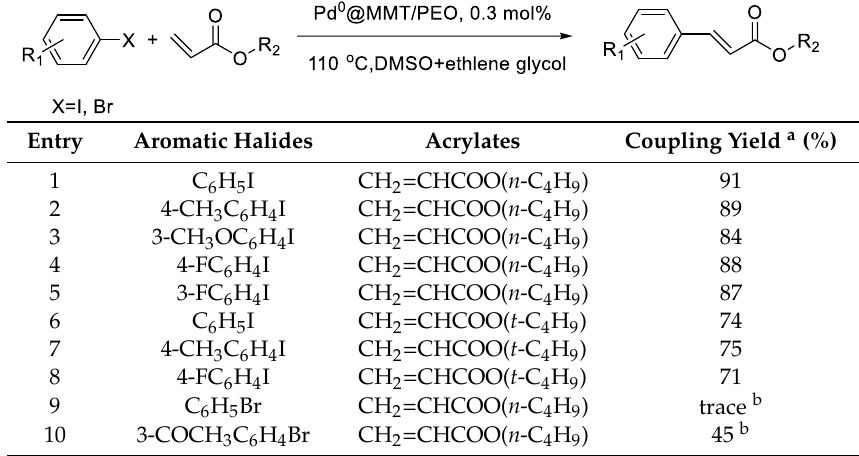
Table 3. Catalytic performances of Pd 0 @MMT/PEO for Heck reactions between aromatic halides with acrylates.